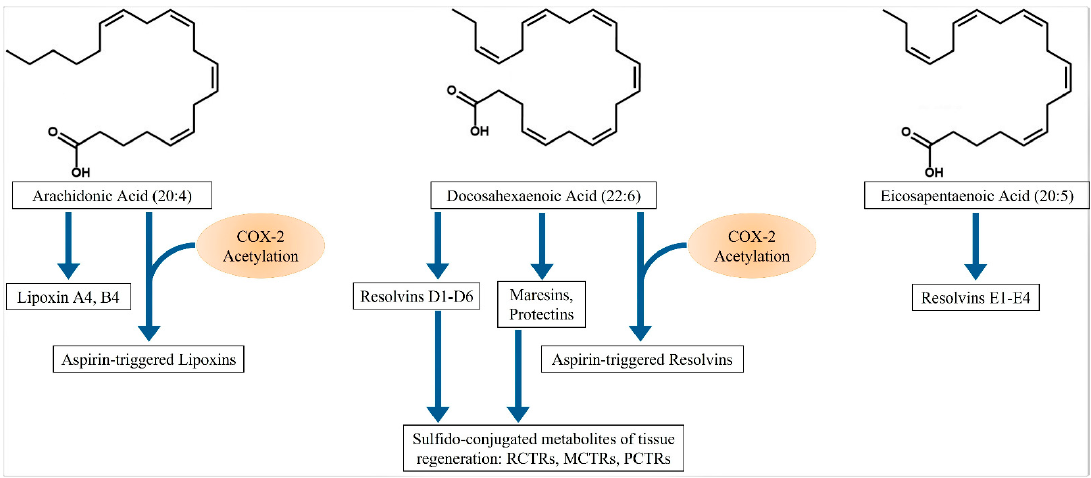
Figure 1. Specialized Proresolving Mediators (SPMs) are produced from arachidonic acid (20:4), docosahexaenoic acid (22:6), and eicosapentaenoic acid (20:5).